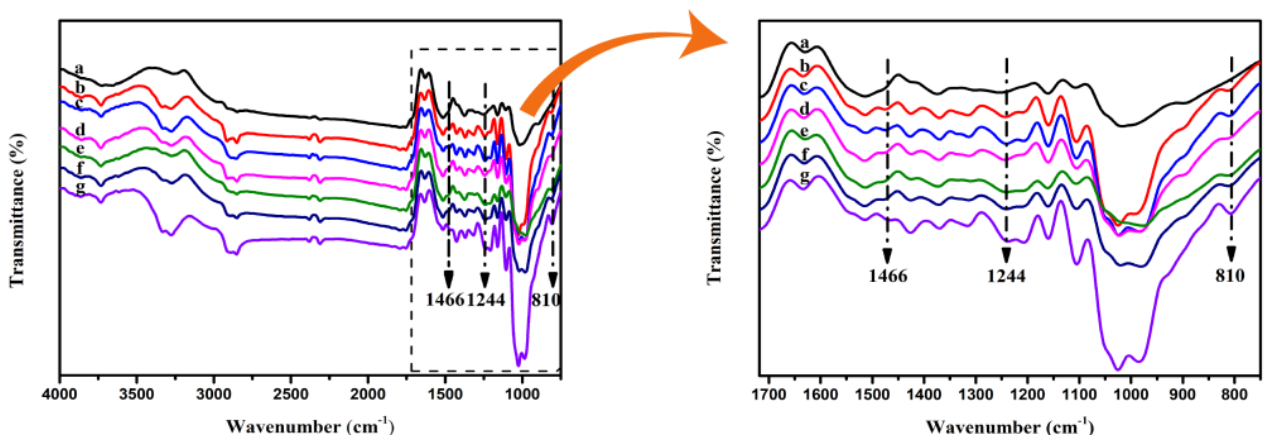
Figure 2. FTIR spectra of original cellulose pulp ( a ), pulp-6-1 ( b ), pulp-6-1.5 ( c ), pulp-9-1 ( d ), pulp-9-1.5 ( e ), pulp-12-1 ( f ), and pulp-12-1.5 ( g ).